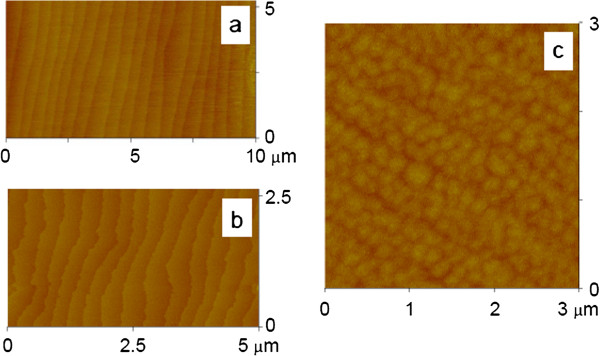
Surface images taken with an atomic force microscope. (a) SrTiO3 (111) substrate prepared by etching and subsequent annealing, (b) SrRuO3/SrTiO3 (001), and (c) SrRuO3/SrTiO3 (111).